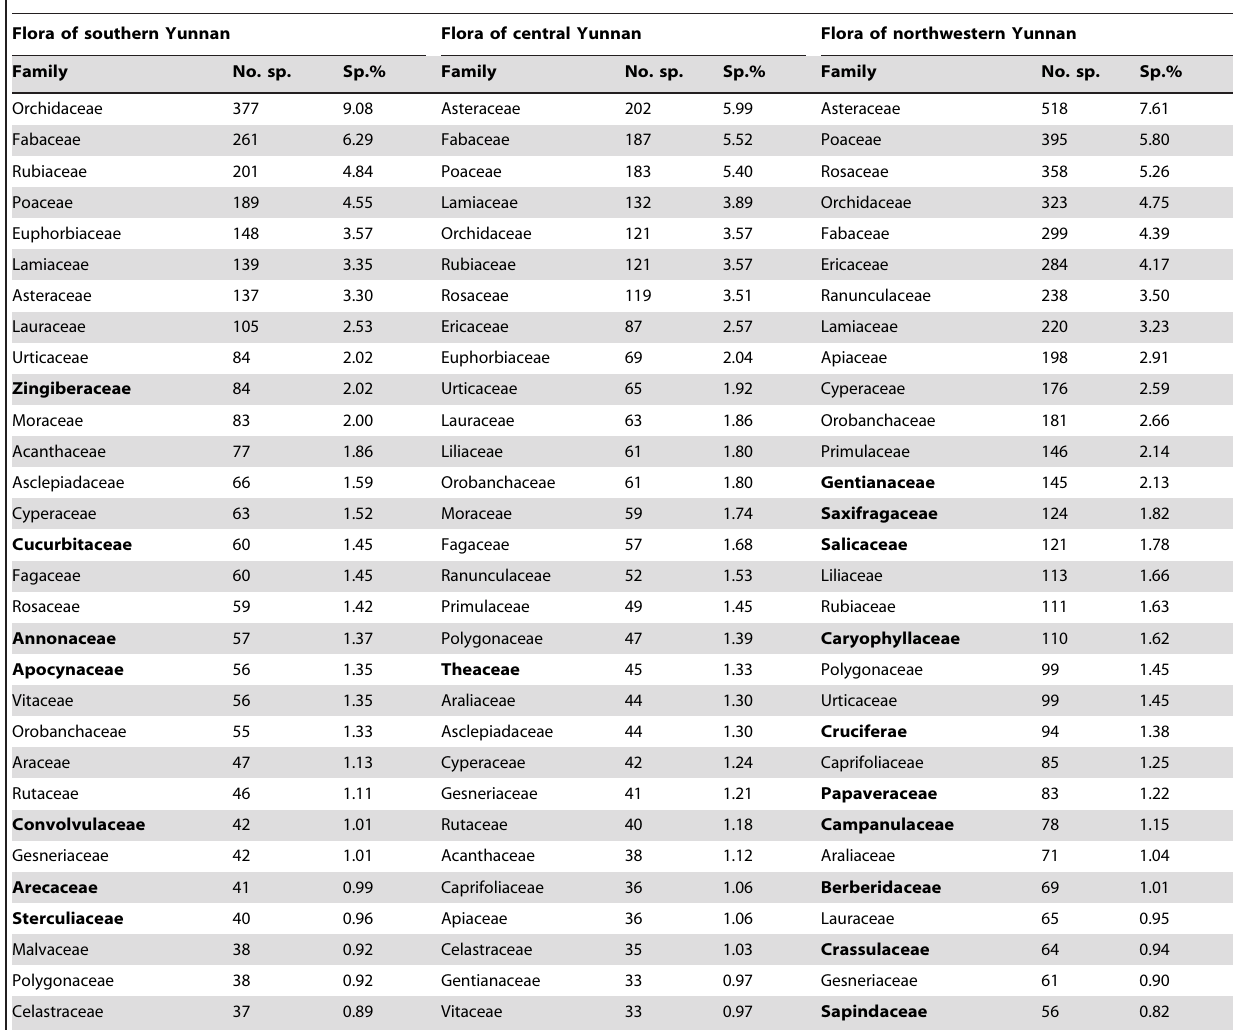
Table 1. Dominant families ranking by species richness of these three compared floras.